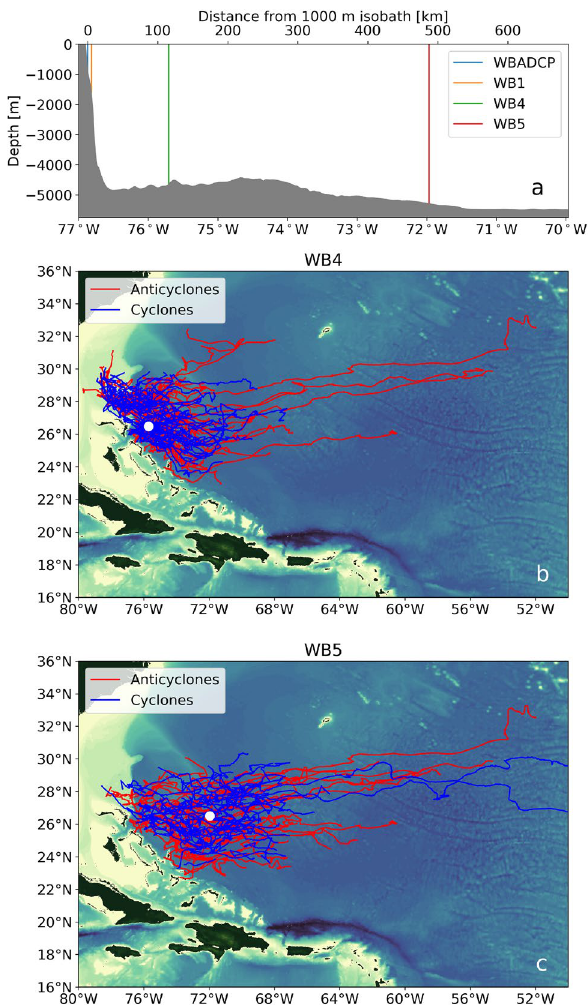
Figure 3. Mesoscale eddies at the RAPID/MOCHA moorings. ( a ) Location of the western boundary RAPID/ MOCHA moorings offshore of the Bahamas. The gray shaded area shows the bathymetry. ( b ) Trajectories of anticyclonic (red) and cyclonic (blue) eddies that pass within two eddy radii of the RAPID/MOCHA mooring WB4 during the mooring deployment (2008–2018). ( c ) As in ( b ) but for the RAPID/MOCHA mooring WB5 during the mooring deployment (2004–2014). The maps in panel ( b , c ) were created using the Python packages cartopy v0.18 and matplotlib v3.3.4, and ETOPO1